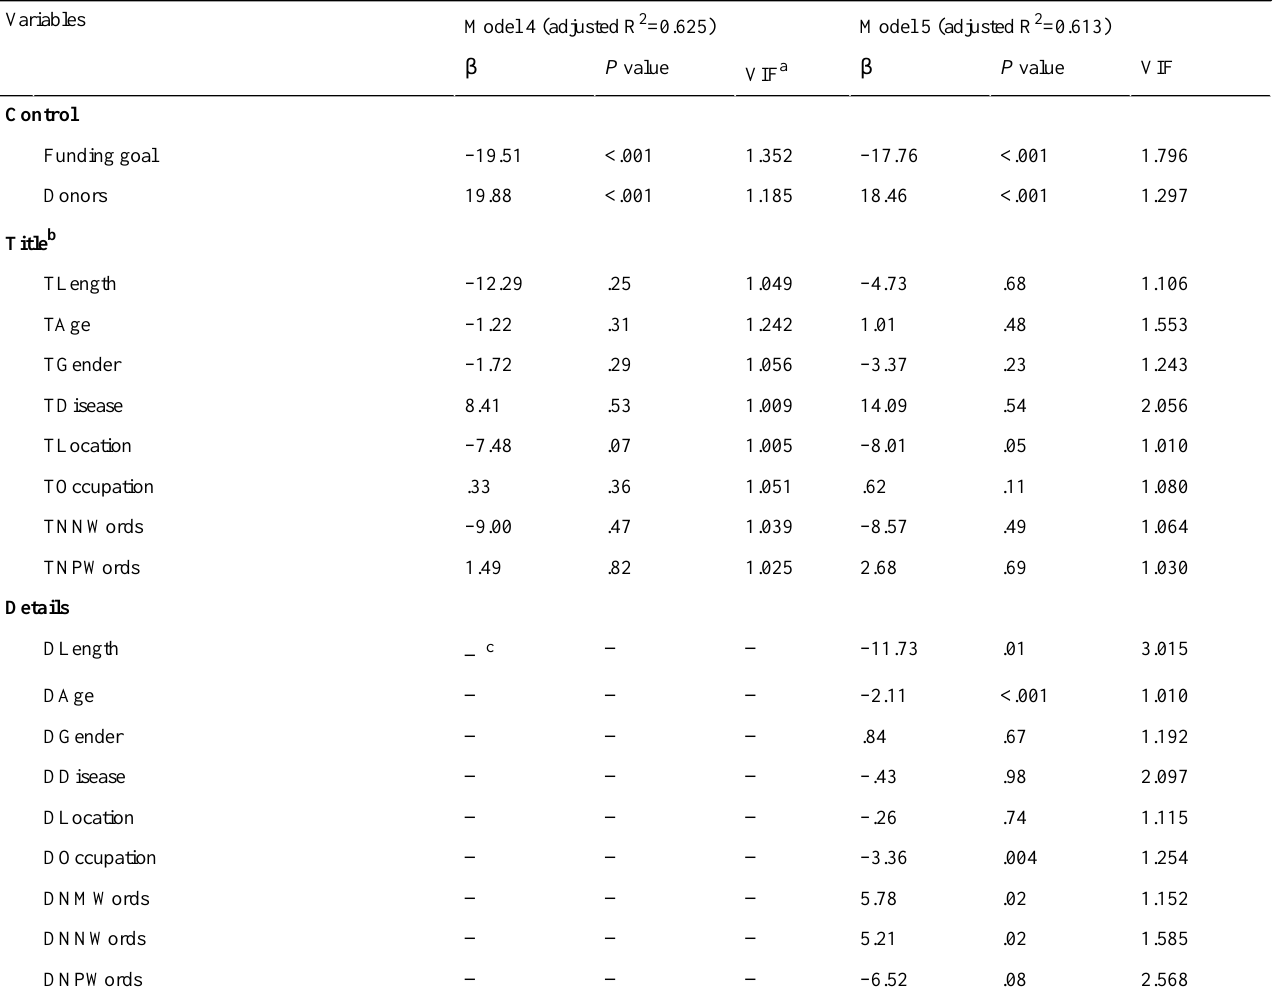
Table 5. Regression results of extent